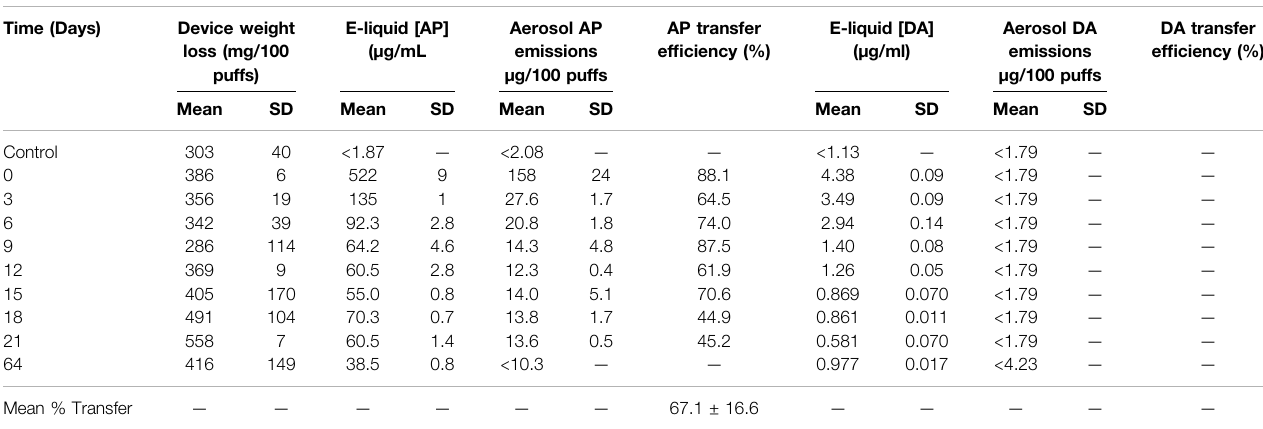
TABLE 3 | Transfer of acetyl propionyl from e-liquid to e-cigarette aerosol. Time